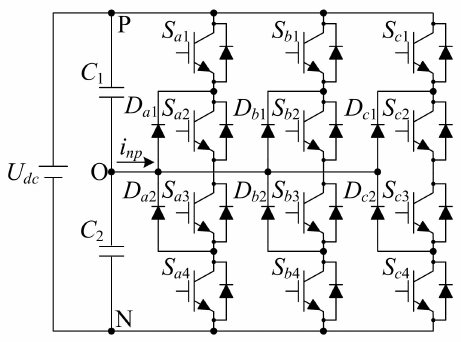
Figure 1. The main circuit of a three-level inverter.